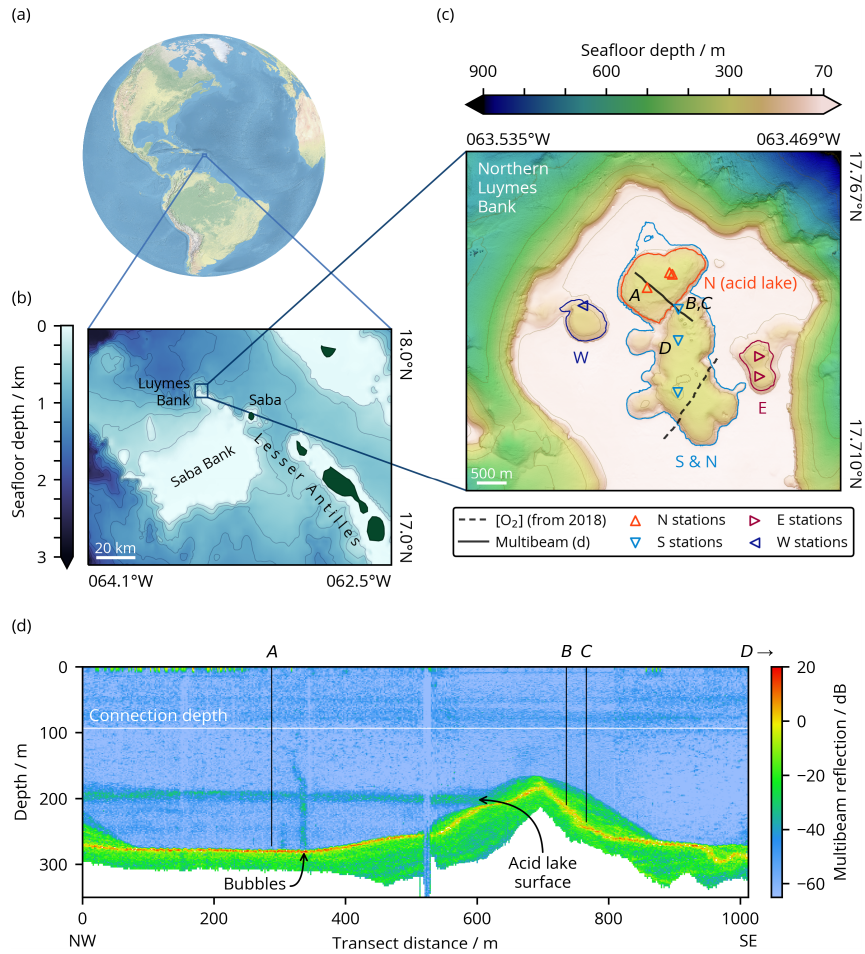
Figure 1. Location of Luymes Bank (a) in the Caribbean and North Atlantic and (b) relative to Saba Bank and the Leeward Islands of the Lesser Antilles (GEBCO Compilation Group, 2020), with contours at 250m depth intervals corresponding to colour-bar ticks. (c) Bathymetry of northern Luymes Bank showing our sampling stations (triangles) and sensor transects (lines). Sinkholes N (containing the acid lake), S, E and W are enclosed by the coloured lines, which are contours at each sinkhole’s connection depth (noting that this is the same for S and the non-acid part of N, labelled “S & N”; Sect. 3.1), and can also be identified from the orientation and colour of the station markers within them (see legend). Contours are at 100m depth intervals plus at 70m, matching the colour-bar ticks. Sampling stations labelled A – D correspond to the same labels in (d) and in Fig. 2h. (d) Water column reflectivity (multibeam) transect across the ridge between sinkholes N (acid lake) and S, marked with a solid line in (c) . The horizontal white line shows the connection depth to the open ocean (93m). Vertical black lines illustrate the maximum depth of measurements at each station (Fig.